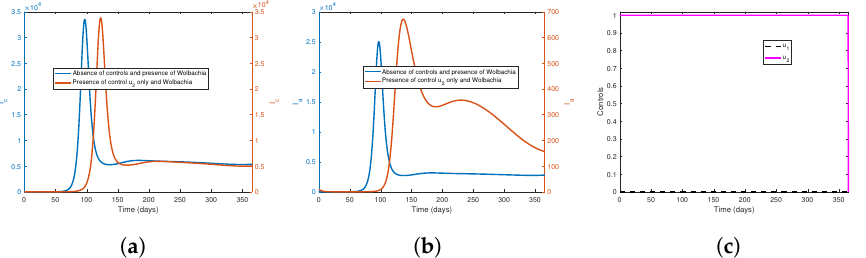
Figure 10. Plots ( a,b ) are the plot of infected child and adult individuals, respectively. Plot ( c ) is the control profile.